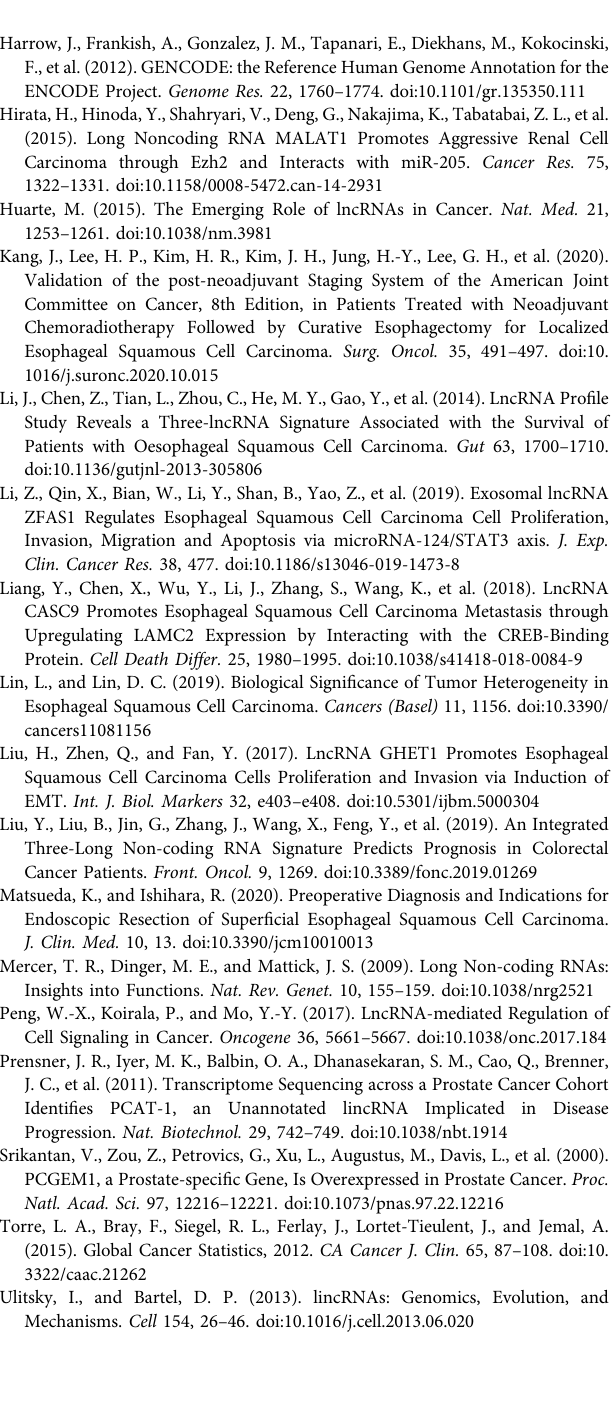
Supplementary Figure S1 | Functional enrichment analysis of the six lncRNAs by Cluego (A) and SubpathwayMiner (B)